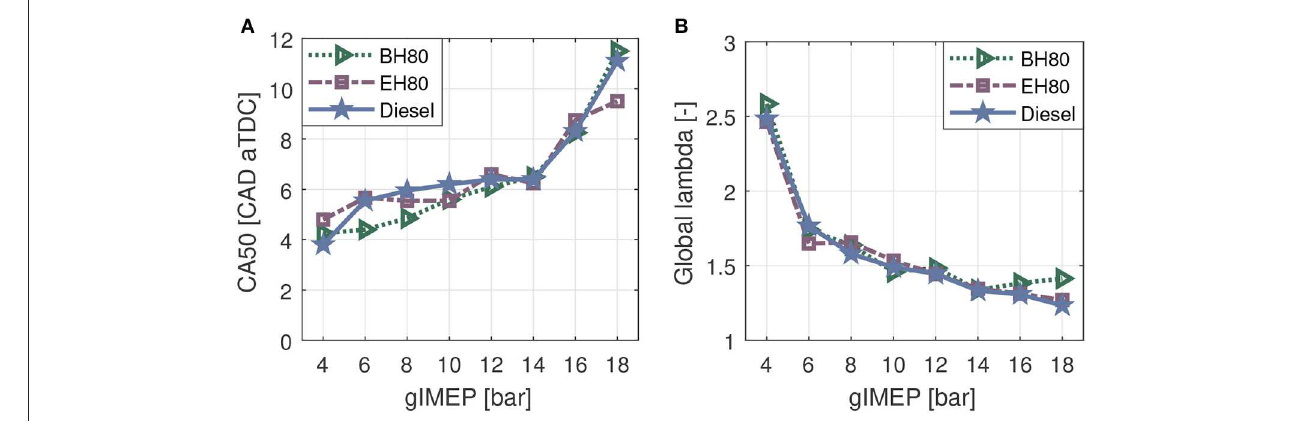
FIGURE 7 | CA50 (A) and global lambda (B) as a function gIMEP.